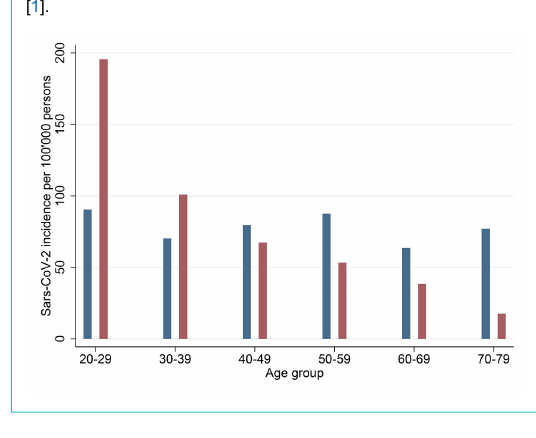
Figure 1: SARS-Cov-2 incidence per 100,000 individuals across different age groups between 4 and 20 April 2020 (blue), and 1 and 27 August 2020 (red). Source: Federal Office of Public Health